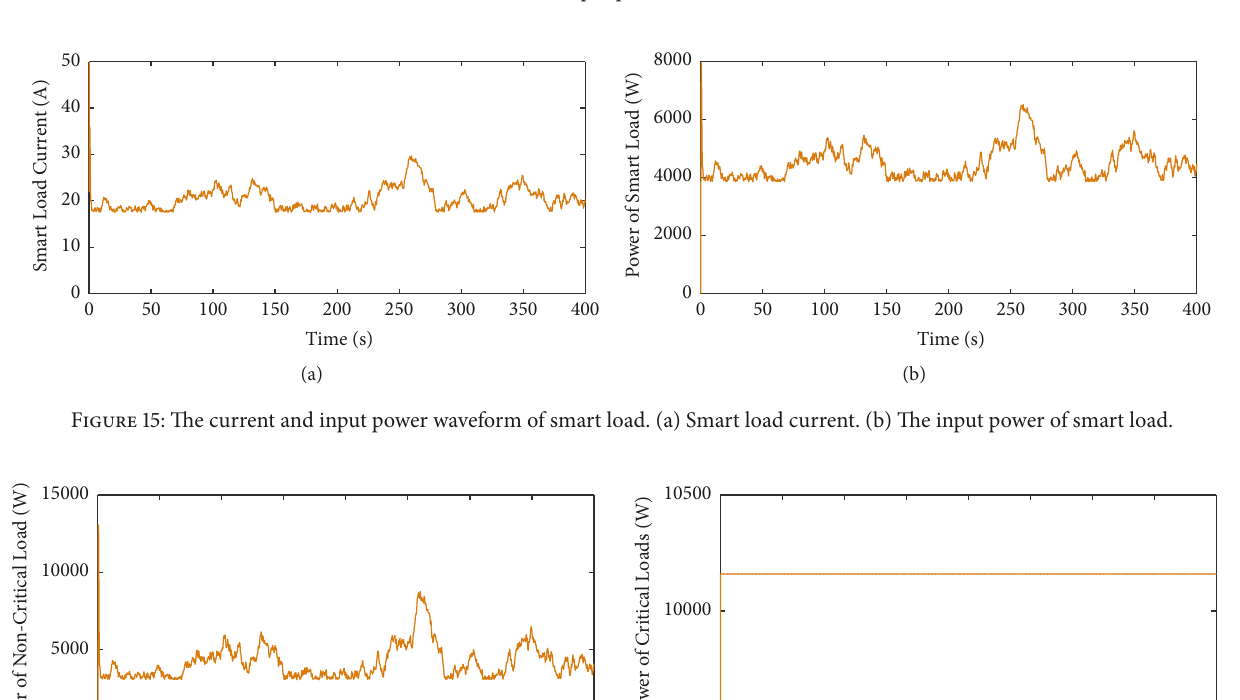
Figure 14: The output power waveform of DG.